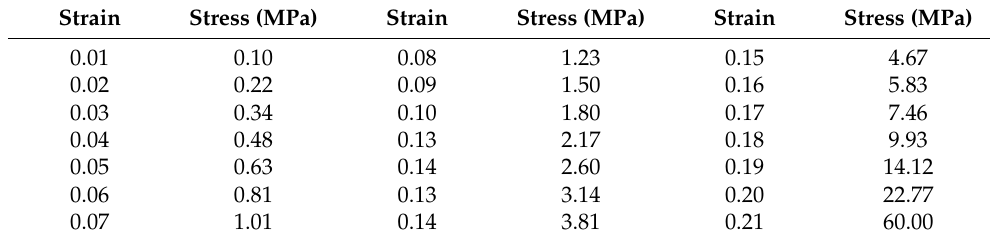
Table 3. Double-yield model parameters of gangue in the gob.